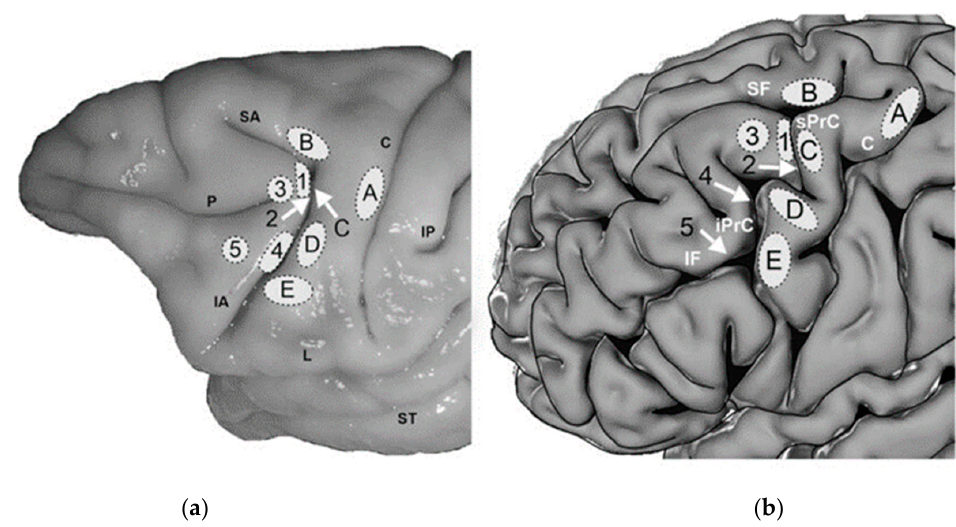
Figure 3. A region at the junction of the prefrontal and premotor cortex in ( a ) rhesus monkeys and primates, ( b ) human brain. Known as the anterior field of vision (FEF), it is primarily involved in controlling eye-movement behavior and spatial attention. Humans have at least two types of forwarding fields of vision. After comparing the letters in the visual nerve regions of the human brain and monkey brain, it was found that the monkey visual cortex corresponds to the human visual cortex; and the principles of spatial attention, dynamic vision control, and attention orientation control are very similar [63]. The letters A, B, C, D, and E in the figure represent the visual cortex regions of the human and monkey brains. The image has been licensed by ELSEVIER.